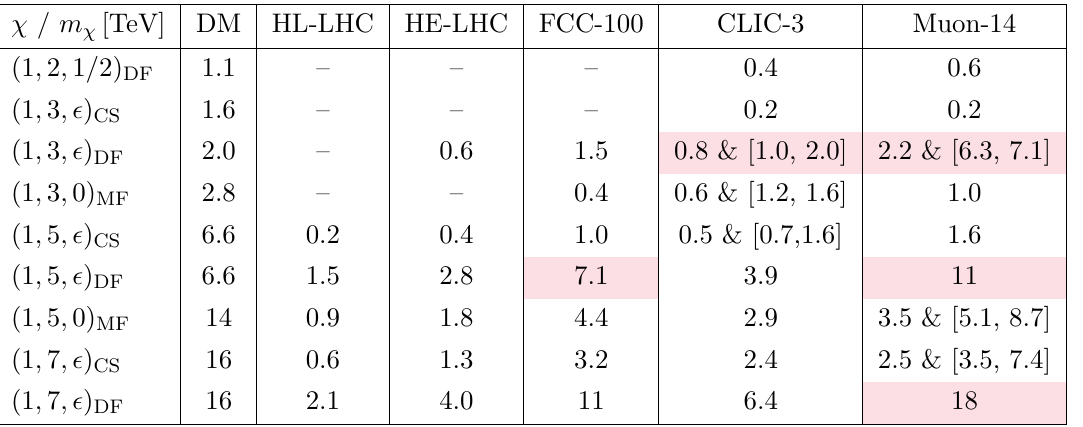
Table 1 . Pure higgsino/wino-like DM and MDM candidates, together with the corresponding masses saturating the DM relic density (second column) and the projected 95% CL exclusion limits from EW precision tests at HL-LHC, HE-LHC, FCC-100, CLIC-3 and Muon-14 (see text for details about center-of-mass energies and luminosities). In the last two columns the numbers in square brackets stand for a mass interval exclusion. The cases where the DM hypothesis could be fully tested are emphasized in light